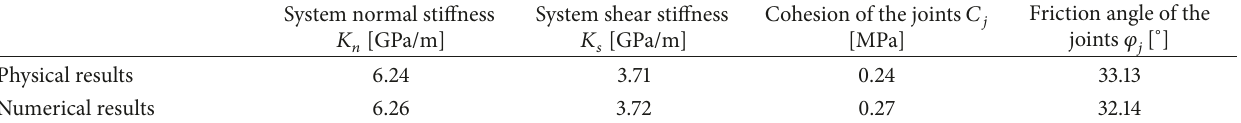
Table 4: Comparison between the macroscale parameters of the numerical simulation and experimental